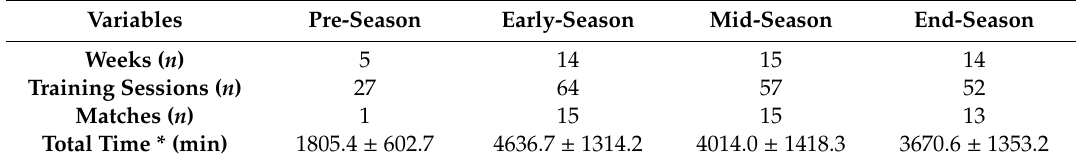
Table 1. Training, match and total time sessions measured separately during the periods of the season. Variables